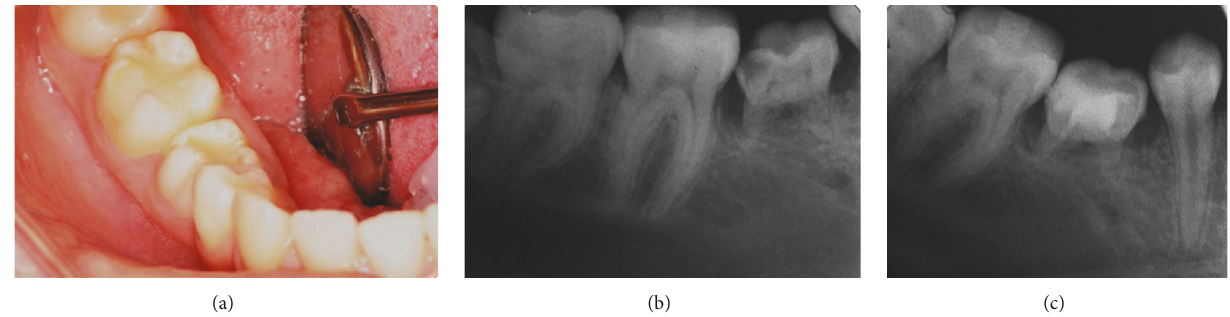
Figure 1: Preoperative intraoral and radiographic views of the patient. (a) Preoperative intraoral view. (b) Preoperative periapical radiograph. (c) Postoperative radiograph after root-canal treatment.